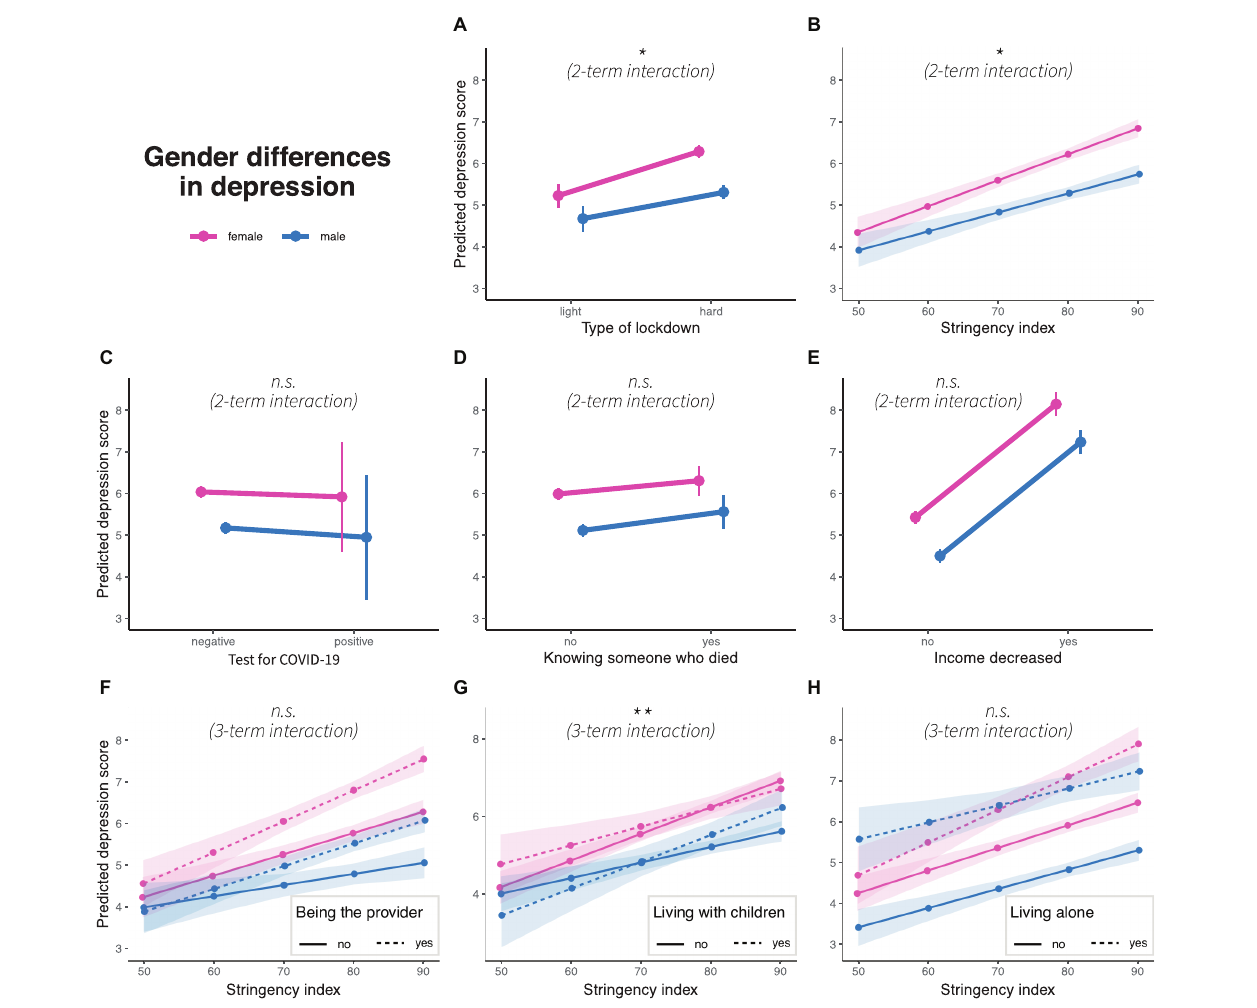
FIGURE 4 | Gender differences in predicted depression scores concerning (A) type of lockdown, (B) stringency index, (C) test for COVID-19, (D) knowing someone who died due to pandemic, (E) income decrease, and interaction of stringency index with (F) being the main household provider, (G) living with children and (H) living alone. Colors represent gender, dots represent marginal means, error bars or ribbons represent 95% confidence intervals. Linetypes represent at the bottom additional interaction terms. Significance of interaction effects are shown in italics; n.s.: non-significance. * p < 0.1 and ** p <